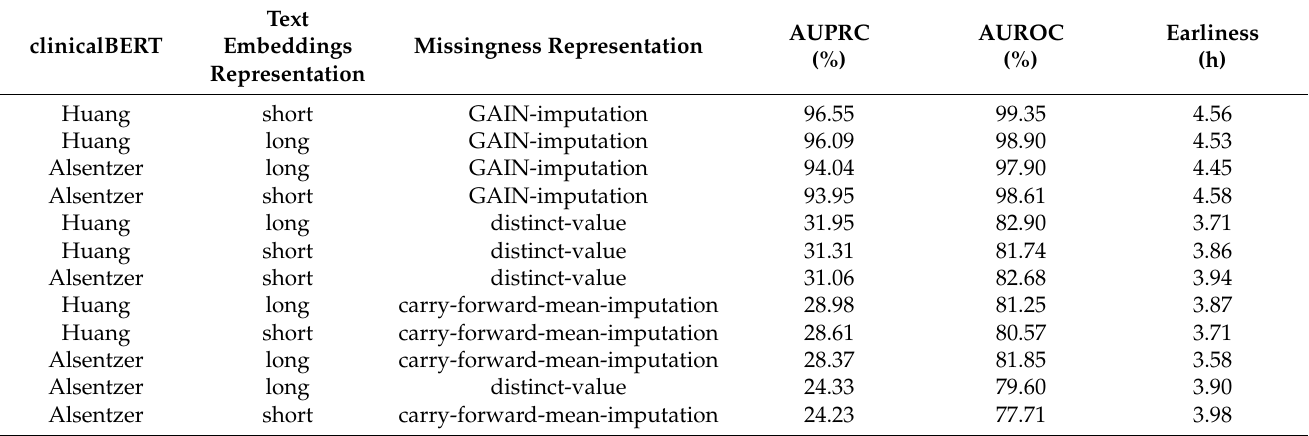
Table 7. Evaluation results using multi-modal (both clinical-text and non-text ) input features in single- server setting.